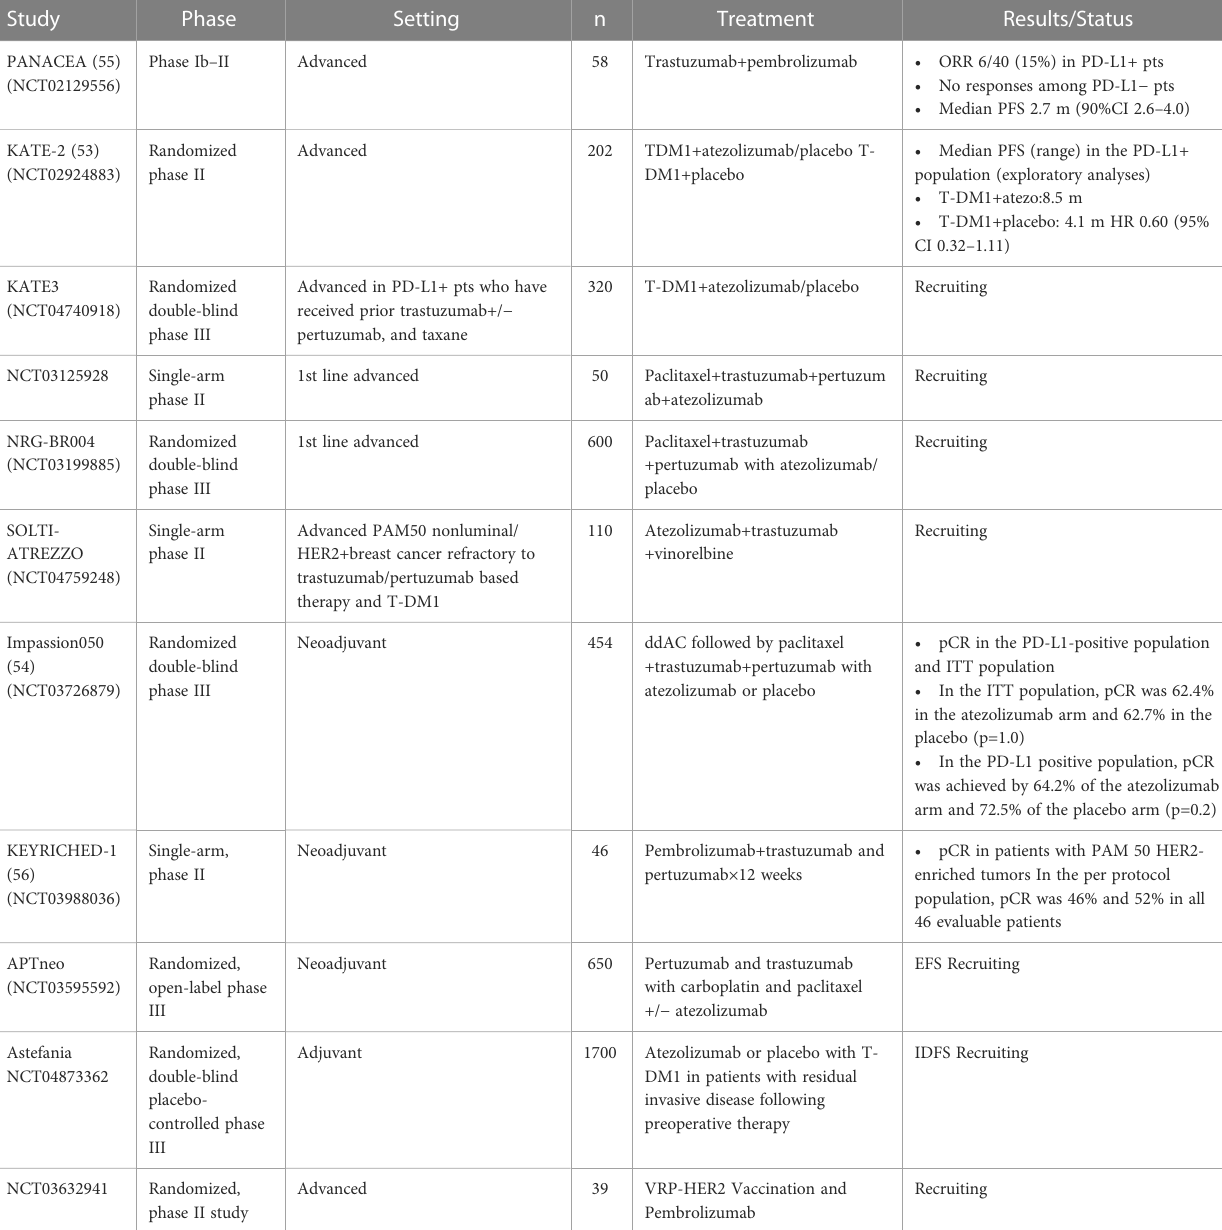
TABLE 1 Clinical trials assessing the combination of checkpoint inhibitors and HER-targeted treatment in HER2+ breast